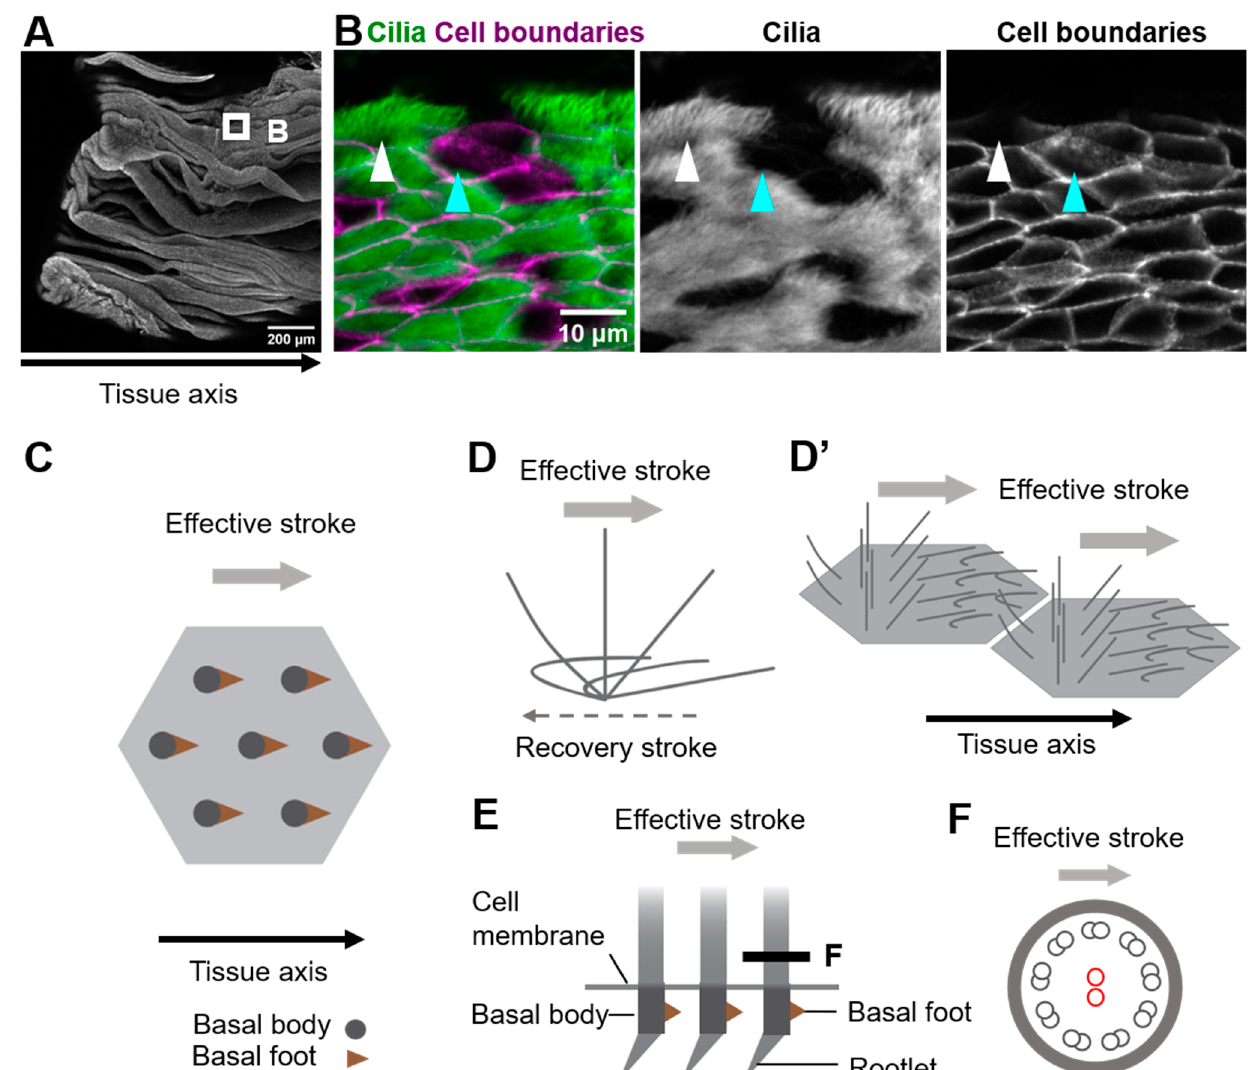
Figure 1. Coordination of cilia movements in multi-ciliated cells. ( A ) Ovary end of the oviduct was opened longitudinally and stained with E-cadherin. ( B ) Cilia (green; acetylated tubulin) and cell boundaries (magenta; E-cadherin) of the oviduct epithelium are visualized. The oviduct epithelium is composed of multi-ciliated cells (white arrowhead) and secretory cells (cyan arrowhead). At the apical surface of those multi-ciliated cells, about 150 cilia are formed on average. ( C ) Representative apical views of multi-ciliated cells. Gray circles and brown triangles indicate basal bodies and basal feet, respectively (also see Figure 1E). Note that the basal foot points in the same direction as the effective stroke (gray arrow). ( D ) Schematic representation of the movement of an individual cilium. Cilia repeat cyclic movements comprised of a fast effective stroke (gray arrow), and a slow recovery stroke (a backward motion; dotted arrow). ( D’ ) A schematic of cilia movements in multi-ciliated cells. Apical surfaces of two multi-ciliated cells are shown. Note that the orientation of effective stroke (or recovery stroke) is consistent with that of the tissue axis. The phase of the beating cycles of cilia shifts between neighboring cilia and generates a metachronal wave, which is a wave-like propagation of cilia movements. ( E ) Lateral view of the basal region of cilia. The basal body has two appendages, the basal foot and the rootlet. ( F ) Cross-sectional view of the cilium along the gray line in E. 9 + 2 microtubules are shown in small circles. The central pair of 9 + 2 microtubules (red circles) run perpendicular to the direction of the effective stroke (gray arrow).